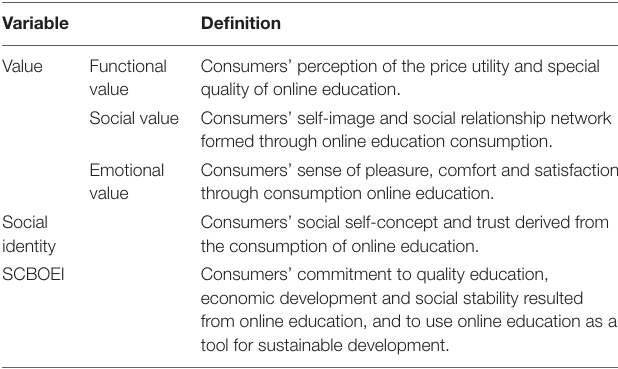
TABLE 1 | Definition of variables in the study. Variable